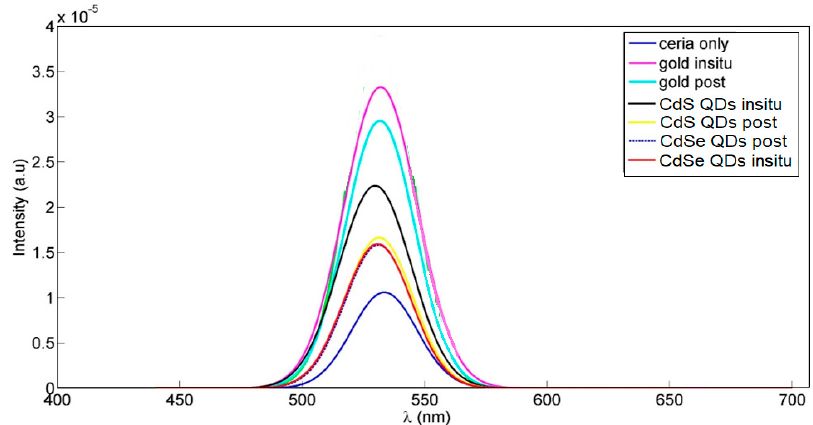
Figure 2. Fluorescence visible emissions of di ff erent plasmonic-embedded-ceria NPs.